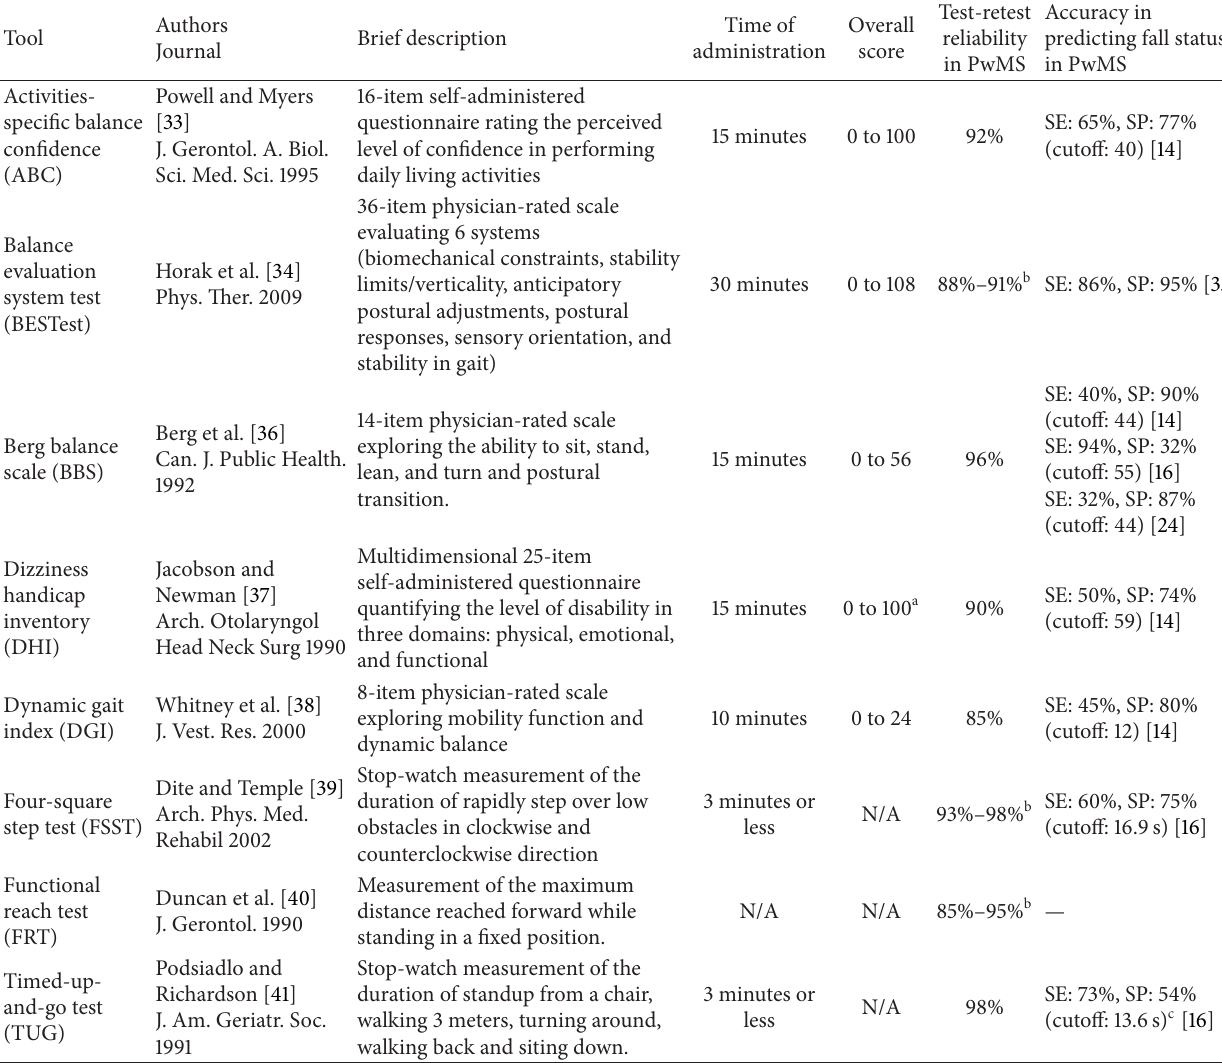
Table 1: Commonly used clinical scales to assess balance in patients with multiple